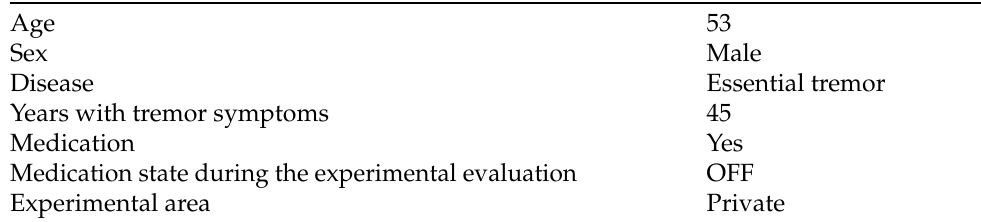
Table 1. ET volunteer clinical profile.